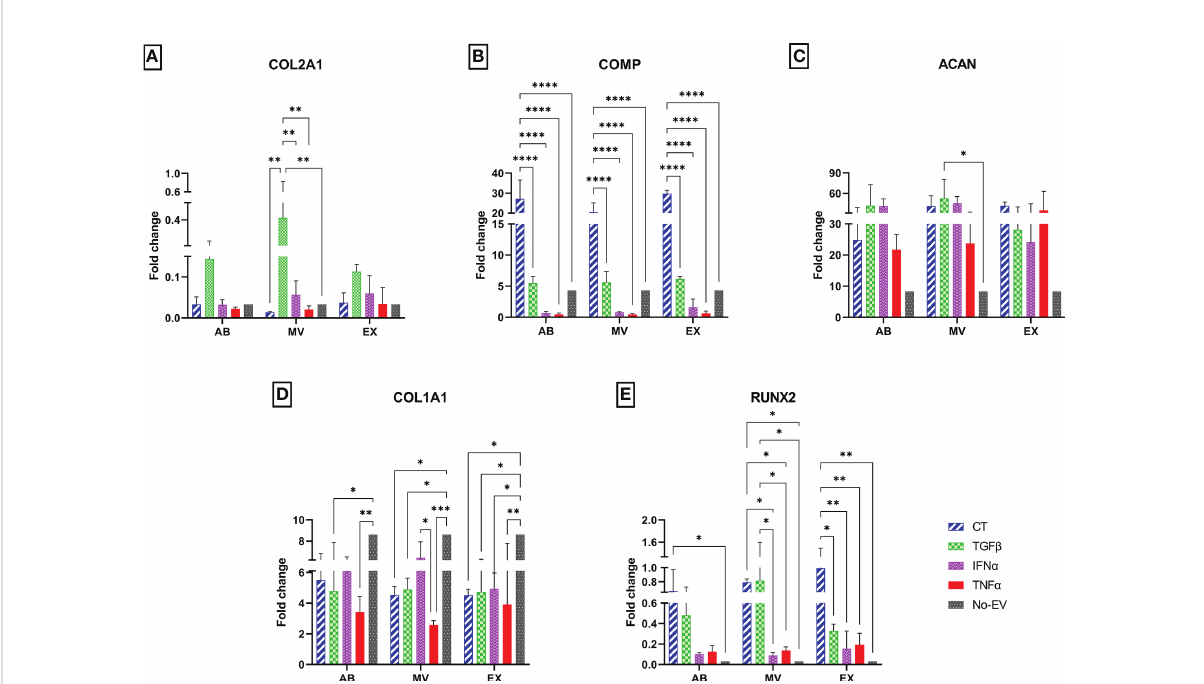
FIGURE 6 Different expression pro fi les of chondrocyte molecular markers. The mRNA relative expression levels in chondrocytes at passage 7 are represented by 2 - DD Ct values with 10 ng cDNA input and were normalized to the reference gene GAPDH and chondrocytes P3 cultured in DMEM 10% FBS. The relative expression level of (A) COL2A1 ; (B) COMP ; (C) ACAN ; (D) COL1A1 ; (E) RUNX2 . Chondrocytes treated with EVs from TGF b -primed UCMSCs expressed stronger COL2A1 and lower COL1A1 . AB: Apoptotic bodies; MV: Microvesicles; EX: Exosomes. CT-AB/MV/EX: chondrocytes treated with AB/MV/EX secreted from non-priming UCMSCs; TGF b -AB/MV/EX: chondrocytes treated with AB/MV/EX secreted from TGF b -primed UCMSCs; IFN a -AB/MV/EX: chondrocytes treated with AB/MV/EX secreted from IFN a -primed UCMSCs; TNF a -AB/MV/EX: chondrocytes treated with AB/MV/EX secreted from TNF a -primed UCMSCs; No-EV: chondrocytes cultured in DMEM/F12 5% EV-depleted FBS and no EV addition. Results were averaged of 3 biological replicates (n = 3). Statistical signi fi cance was determined by Two-Way ANOVA and indicated by: * where p < 0.05; ** where p < 0.01; *** where p < 0.001; **** where p < 0.0001. Error bars indicate ±